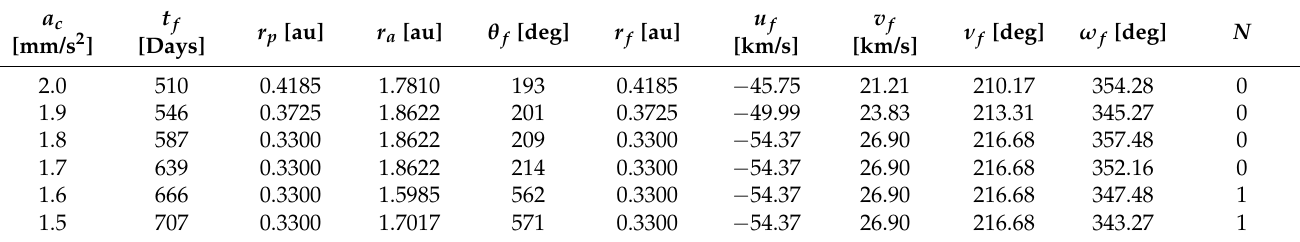
Table 1. Optimal transfer trajectory characteristics as a function of the E-sail propulsive